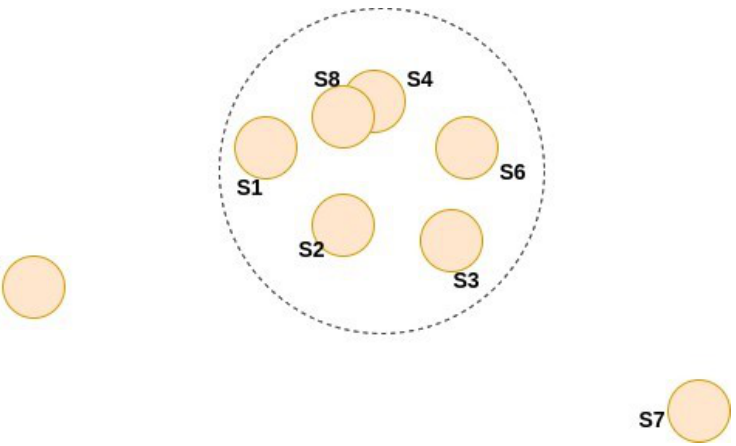
Figure 2. An example for hybrid voting. At round-1, segmentator 5 and segmentator 7 will be excluded since they are far from the others, the rest are kept for round-2 using (either soft or hard) arithmetical